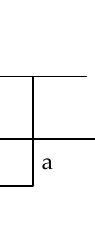
Figure 1. Preisach operator.